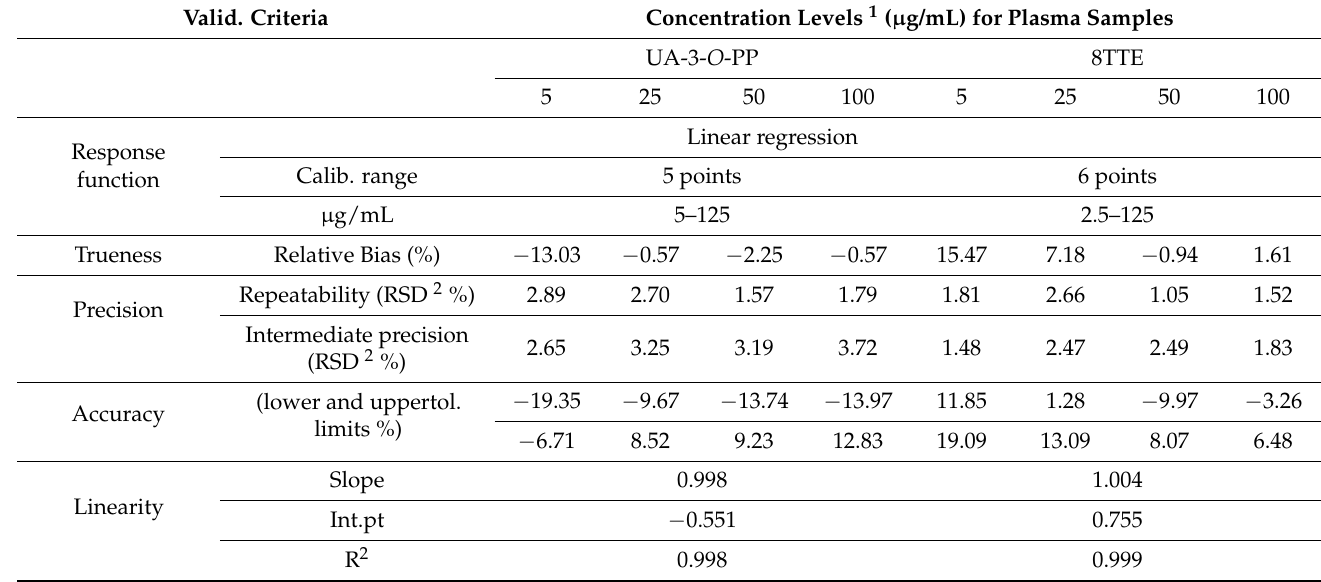
Table 2. Validation results obtained for the quantification method of UA-3- O -PP and 8TTE in spiked plasma. Valid.